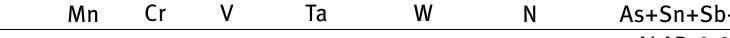
Table 1: EUROFER 97 chemical composition (mass, %) (Ni, Mo, Cu, Nb, Al, B, Co: as low as possible (ALAP), S = 20 ppm, P = 100 ppm) C Mn Cr V